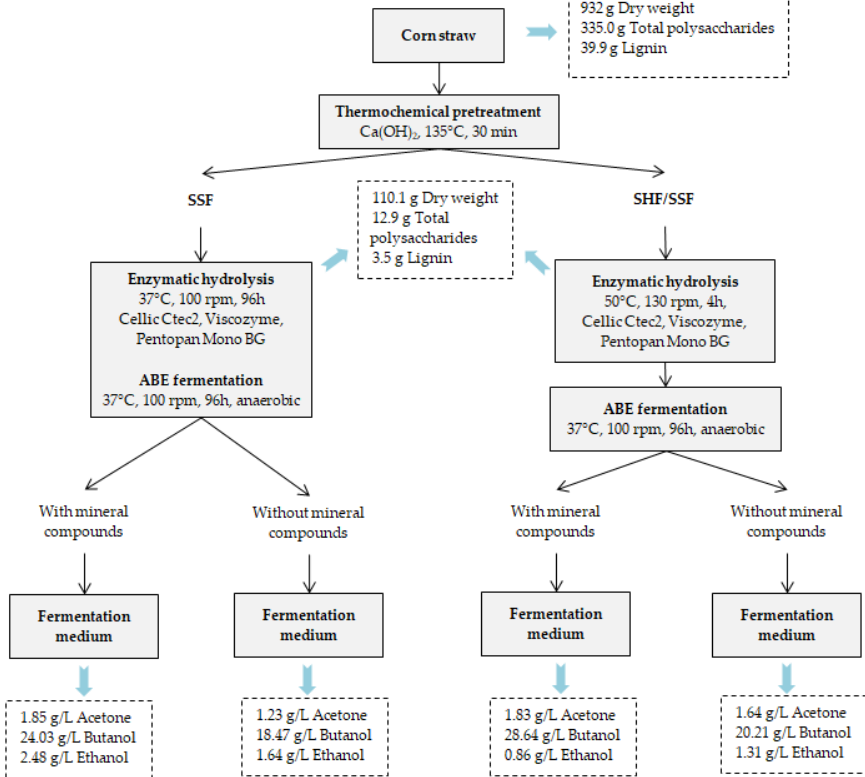
Figure 3. Mass balance of the process ABE fermentation including pretreatment and enzymatic hydrolysis.